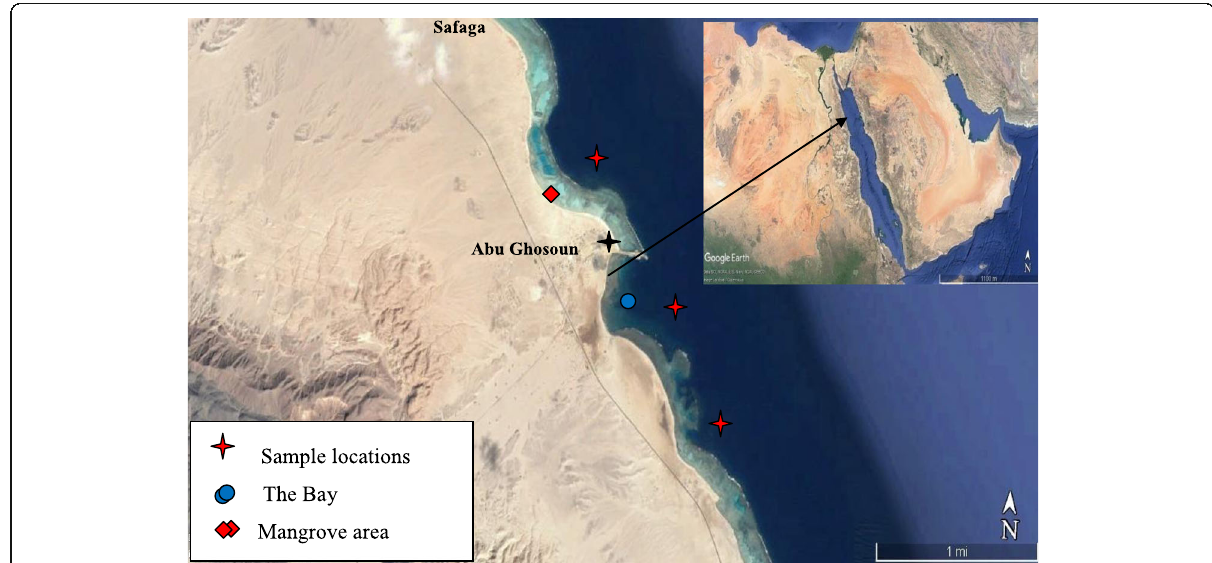
Fig. 1 The location of the study site at the Red